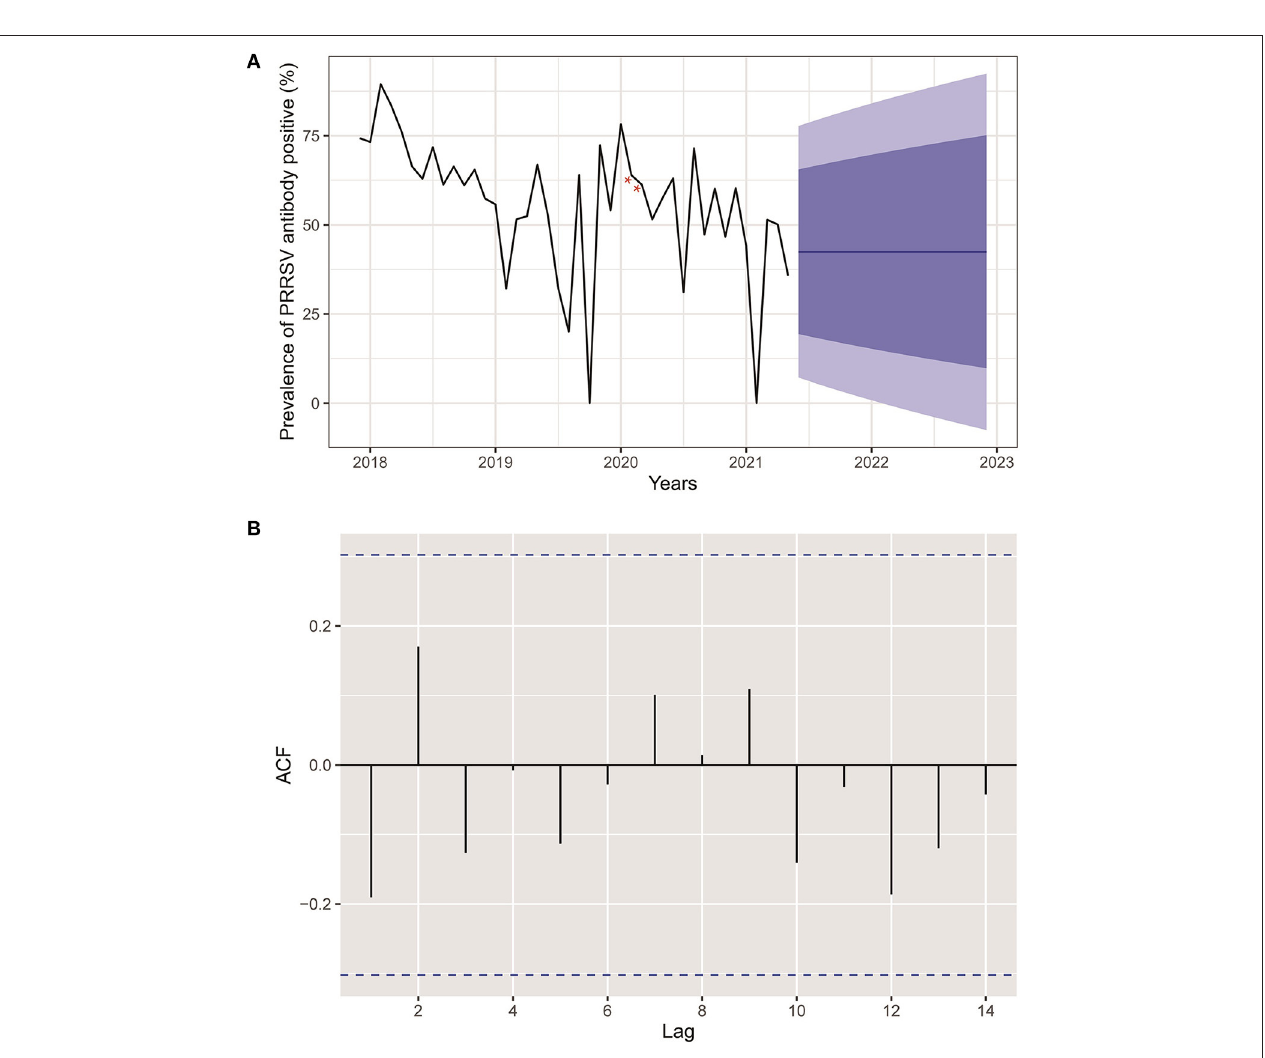
FIGURE 3 | (A) Actual and forecasted PRRSV prevalence. Black line was the actual PRRSV prevalence from December 2017 to May 2021. The blue line represented the forecasted PRRSV prevalence in the next 19 months. The dark and light blue areas were 80 and 95% CI of forecasted PRRSV prevalence, respectively. Red stars indicated interpolated values for PRRSV prevalence of February and March 2020 deficiency because of COVID-2019. (B) Autocorrelation plots of PRRSV